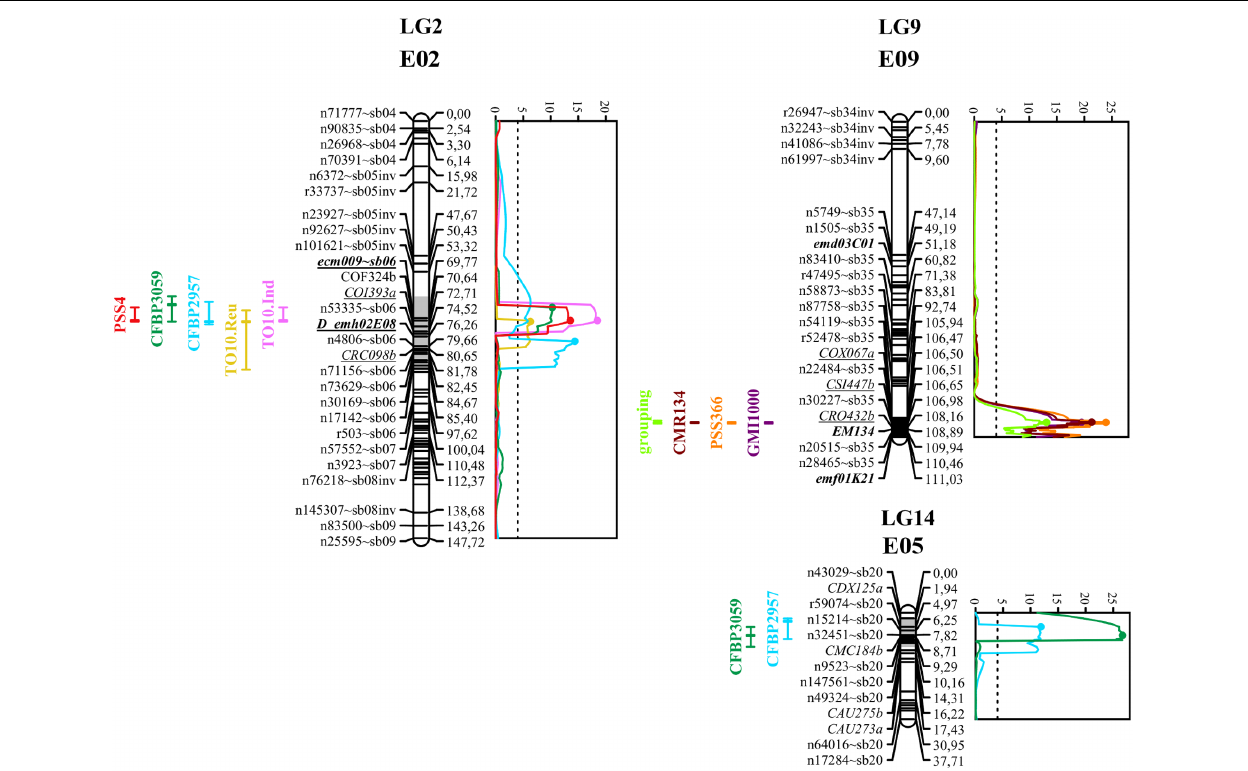
FIGURE 3 | Graphs of LOD scores, and intervals of EBWR2 , EBWR9 , EBWR14 resistance QTLs to R. solanacearum species complex positioned on their respective linkage group and chromosome (LG2-E02, LG9-E09, and LG14-E05). Strains controlled by EBWR2 , EBWR14 , EBWR9 QTLs are indicated on the left of each LG. Eggplant/tomato synteny blocks are indicated as “ ∼ sb” at the end of each marker name. Lebeau et al. (2013) markers, linked to resistant QTLs, are underlined. Markers in bold are SSRs. QTL intervals are indicated on the left of each linkage group (LG); LOD curves are plotted on the right of each linkage group (LG). QTL intervals and LOD curves were obtained using CIM for combined seasons (strains CFBP2957, CFBP3059, and PSS4) and individual assays (strains TO10.Indonesia and TO10.Réunion). QTL intervals and LOD curves were obtained with SIM method (strains GMI1000, PSS366, and CMR134) on an individual as well as combined basis. LOD curves were obtained before refining the QTL position with refineqtl R command, whereas QTL intervals were obtained after the refineqtl command.